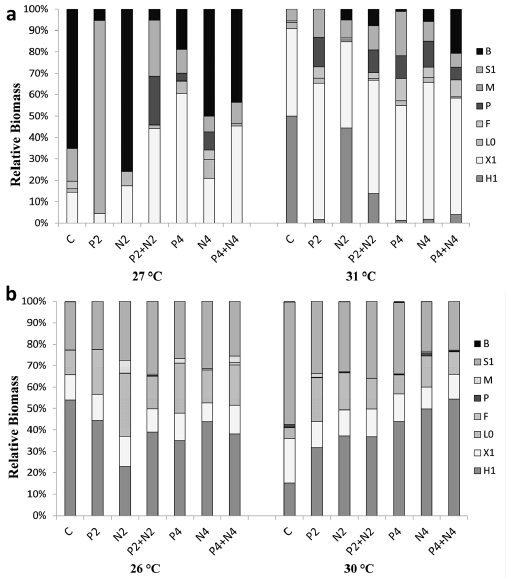
Figure 4. Relative biomass (%) of the Reynolds Functional Groups (RFG) in different nutritional enrichment and temperature treatments, for the rainy season (a) and dry season (b).